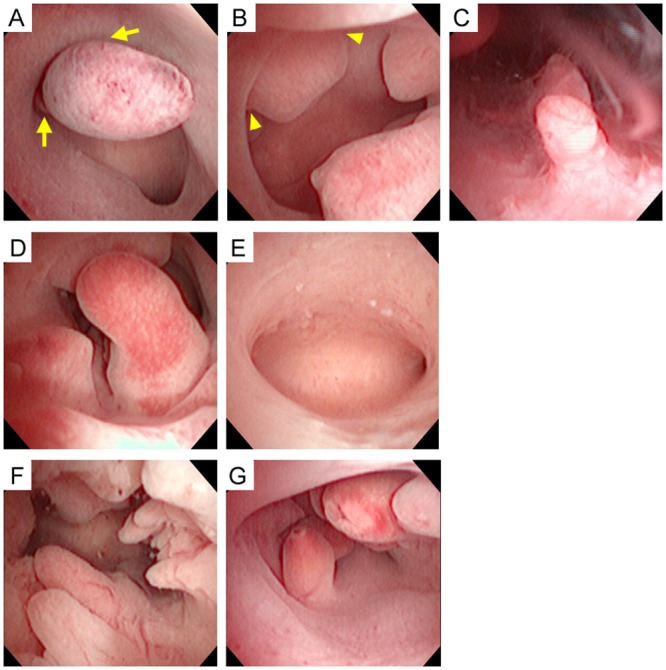
Office hysterosocpic examination of endometrial polyps.
(A) Pedunculated endometrial polyps are defined with the angle of polyp surface to endometrium < 90 degrees (arrow). (B) Sessile endometrial polyps are shown with an angle ≥ 90 degrees (arrowhead). (C) Presence of intracavitary bleeding is noted. (D, E) A woman has three endometrial polyps, and the follow-up hysteroscopy does not find polyp recurrence 3 months after polypectomy. (F, G) Another woman has ten endometrial polyps, and postoperative hysteroscopy reveals polyp recurrence 8 months after polypectomy.